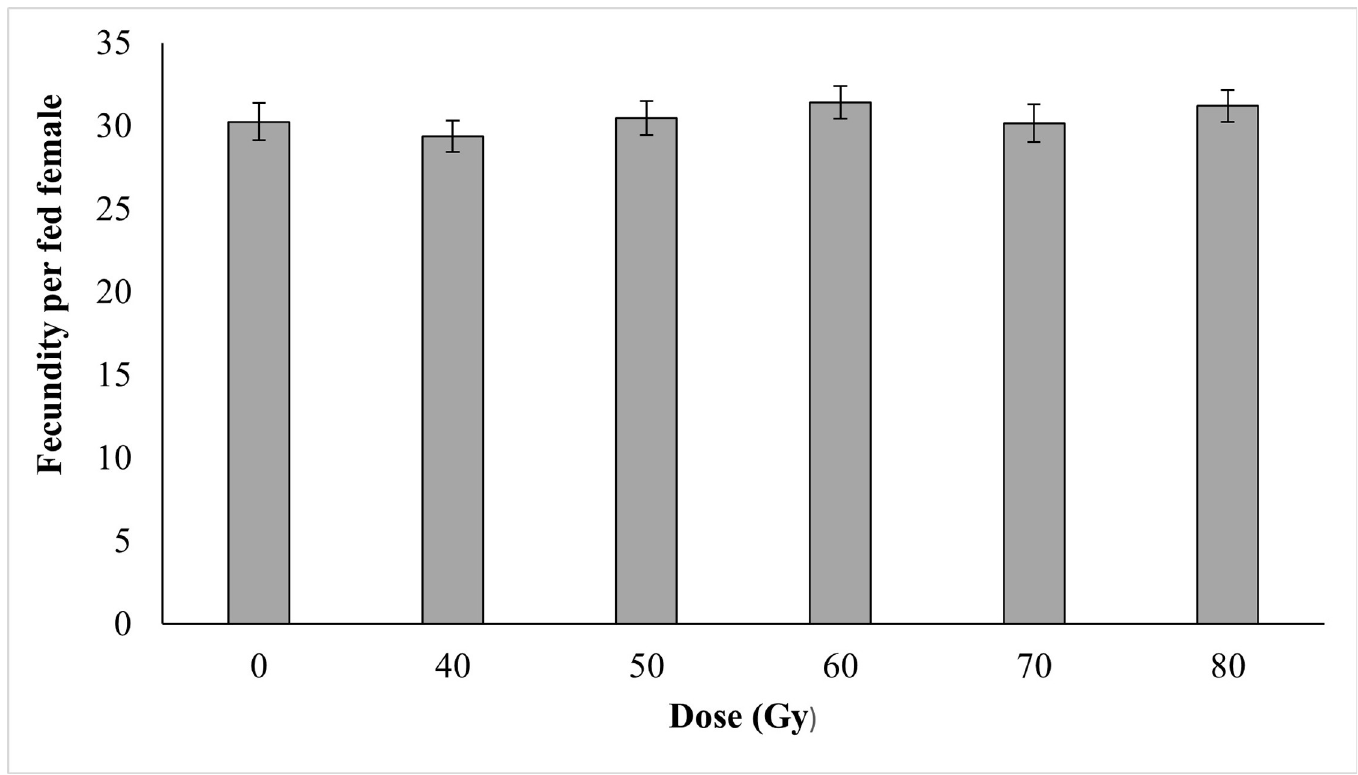
Fig 4. Fecundity per fed female of fertile males matted with irradiated females Ae . aegypti following exposure to different irradiation doses.